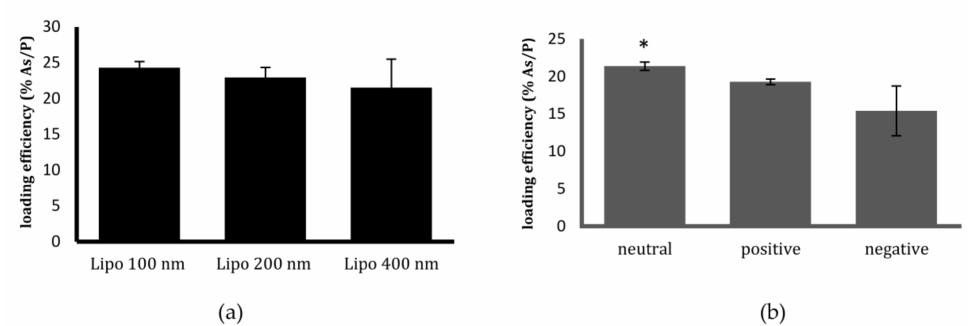
Figure 1. Loading efficiency of synthesised liposomes by inductively coupled plasma optical emission spectrometry (ICP-OES). Loading efficiency (% phospholipids/encapsulated arsenic—As/P) of liposomes of ( a ) different sizes and ( b ) different charges. All of the different-sized liposomes (100 nm, 200 nm, and 400 nm) have a neutral charge, whereas all of the different-charged liposomes (neutral, positive, and negative) are 100 nm in size. Data are presented as mean ± standard deviations (SD) of three replicate measurements of at least three independent experiments. An unpaired t test ( p > 0.05) was used to test for any significant difference in the loading efficiency of liposomes of three sizes (ranging from 100 to 400 nm), and three charges (neutral, negative, and positive). No significant difference was observed between the liposomes of different sizes, although neutral liposomes displayed a significantly higher loading efficiency than the others (* p <